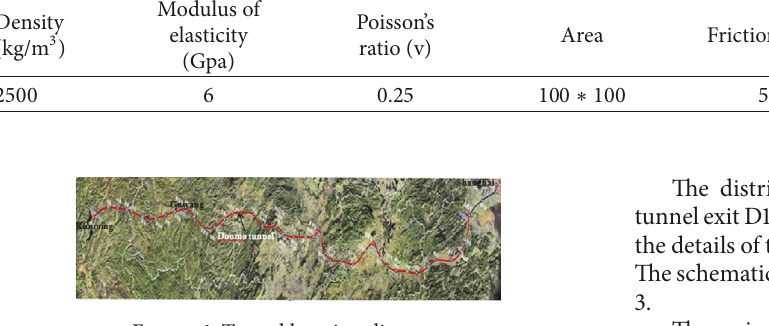
Figure 1: Tunnel location